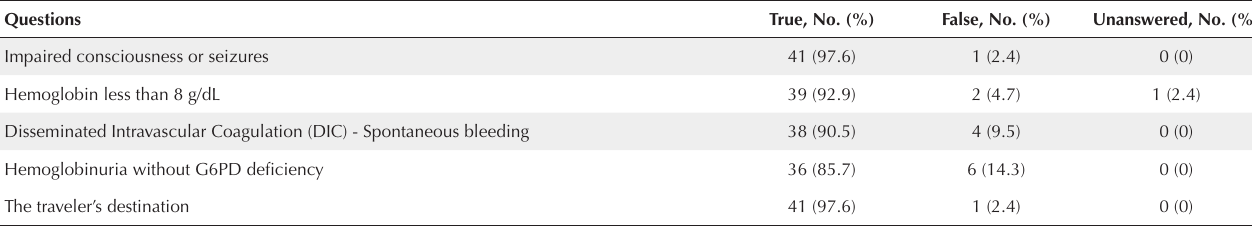
Table 3. The Important Features of Severe falciparum Malaria in Adults Questions